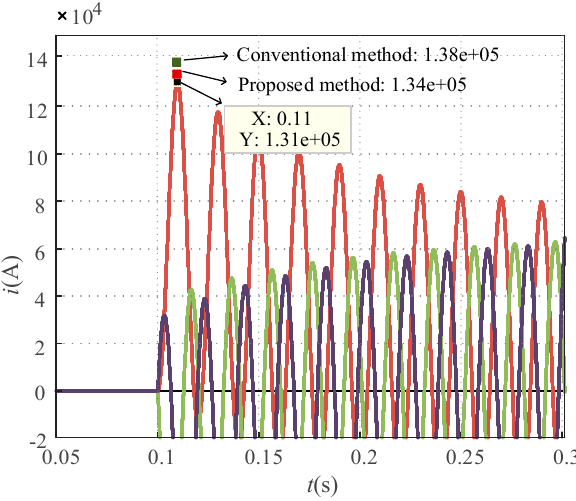
Figure 14. Three-phase short-circuit current of Kongdian substation.